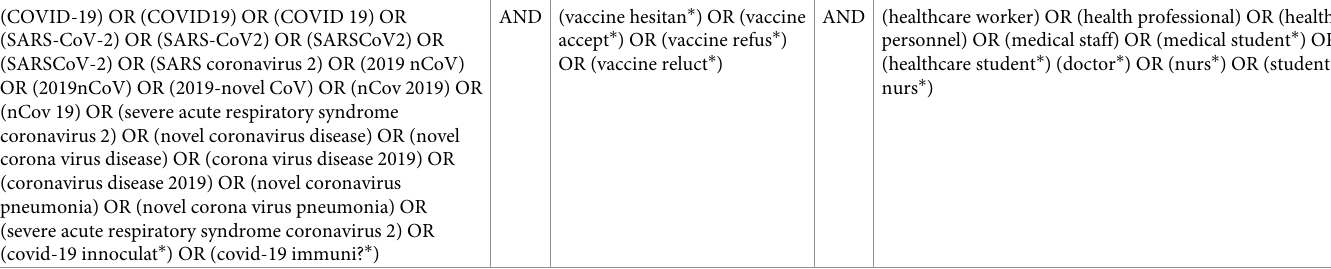
Table 2. Search syntax used to search